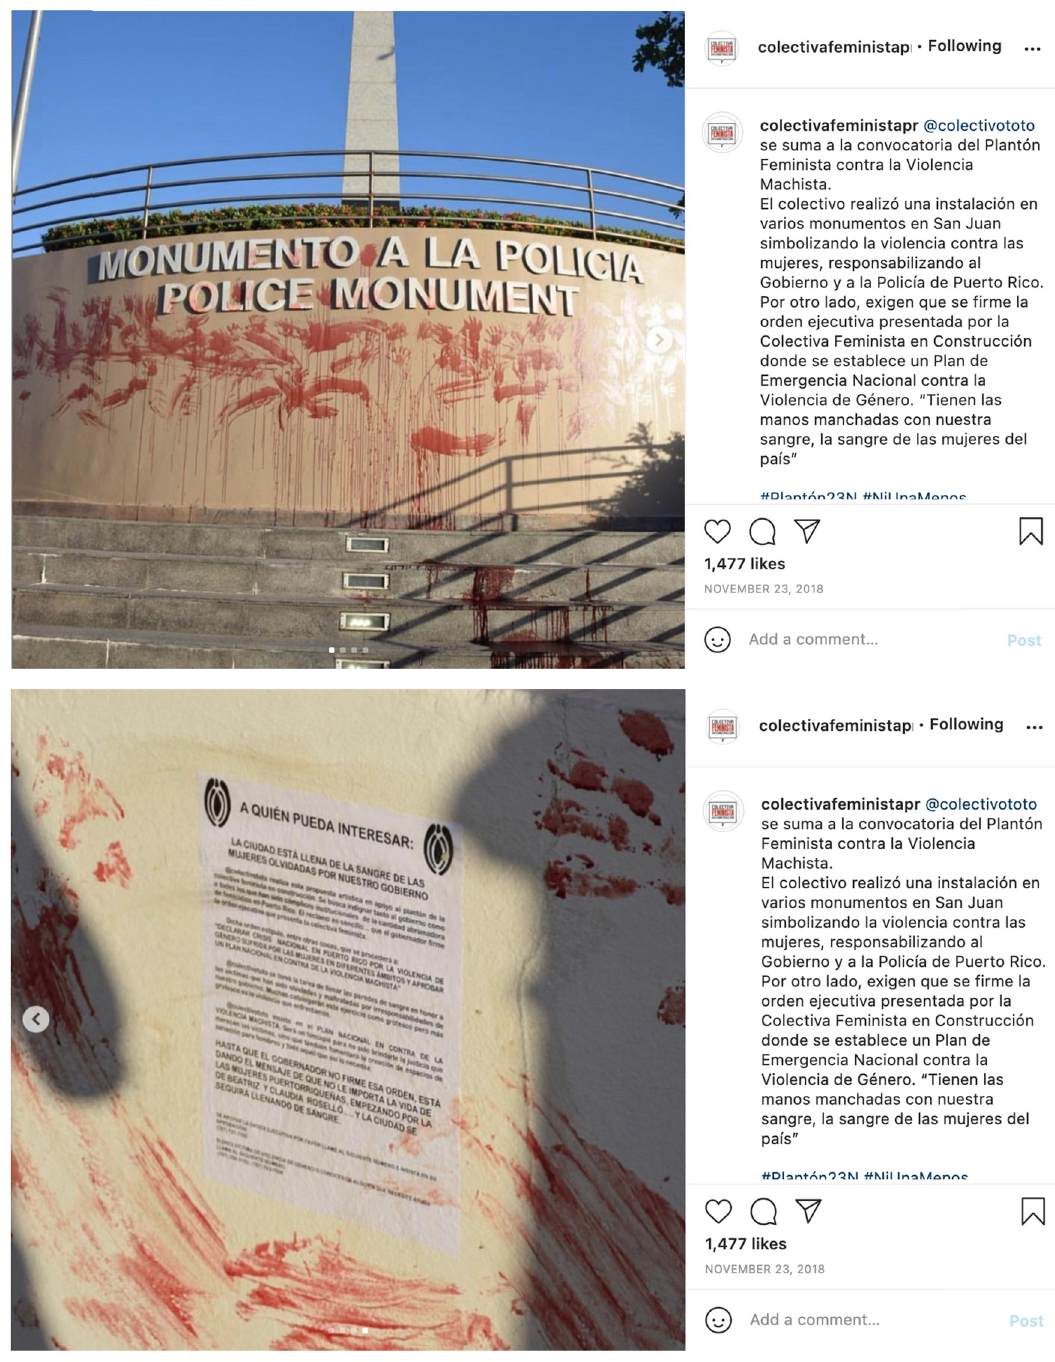
Figure 3: Screenshot from Colectiva Feminista en Construcción Instagram